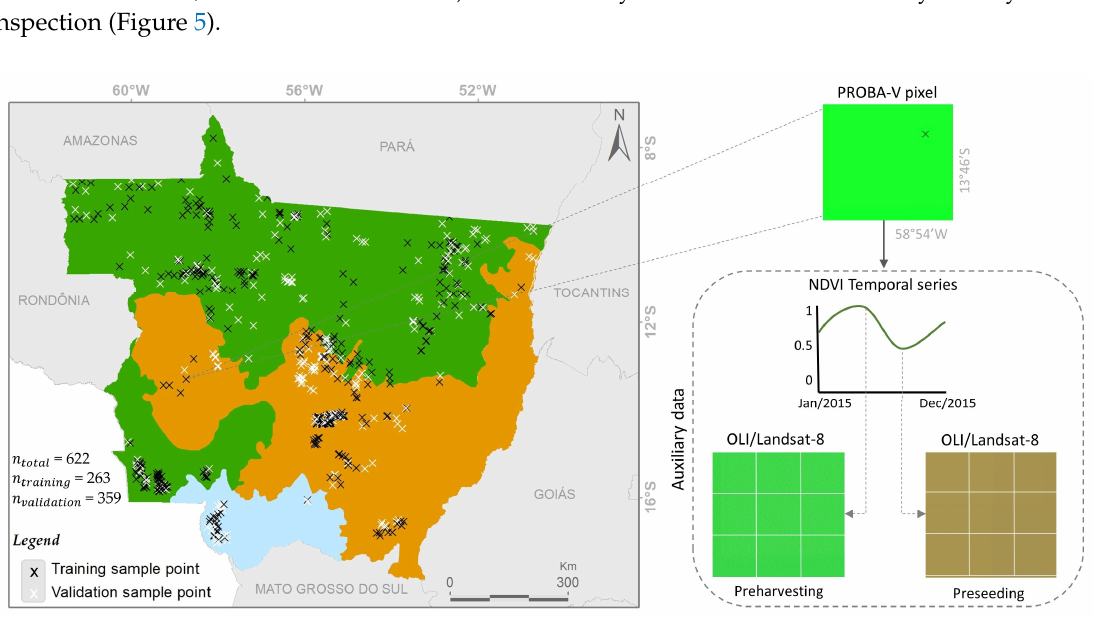
Figure 5. Location of 622 training and validation samples in the study area. In the upper right, the RGB (Red-Green-Blue) color composite of median PROBA-V data: Red, NIR, and blue of an agricultural sample, with respective conceptual behavior of the ancillary data from MODIS NDVI and the two seasons of the Landsat-8 OLI (RGB:654) in the bottom right.